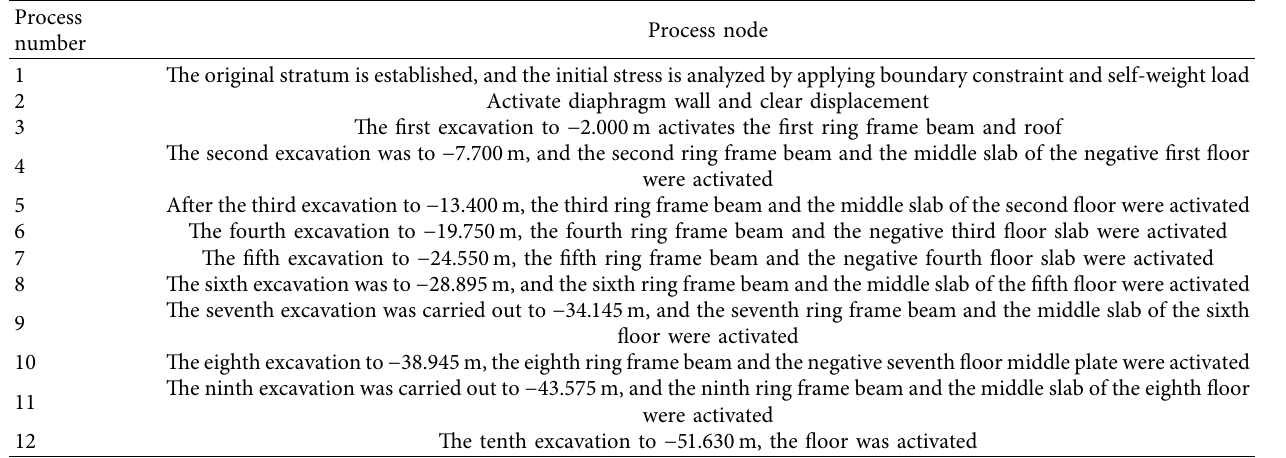
Figure 8. In the contour plot, the one on the left is the west wall, and the one on the right is the east wall (the same below).